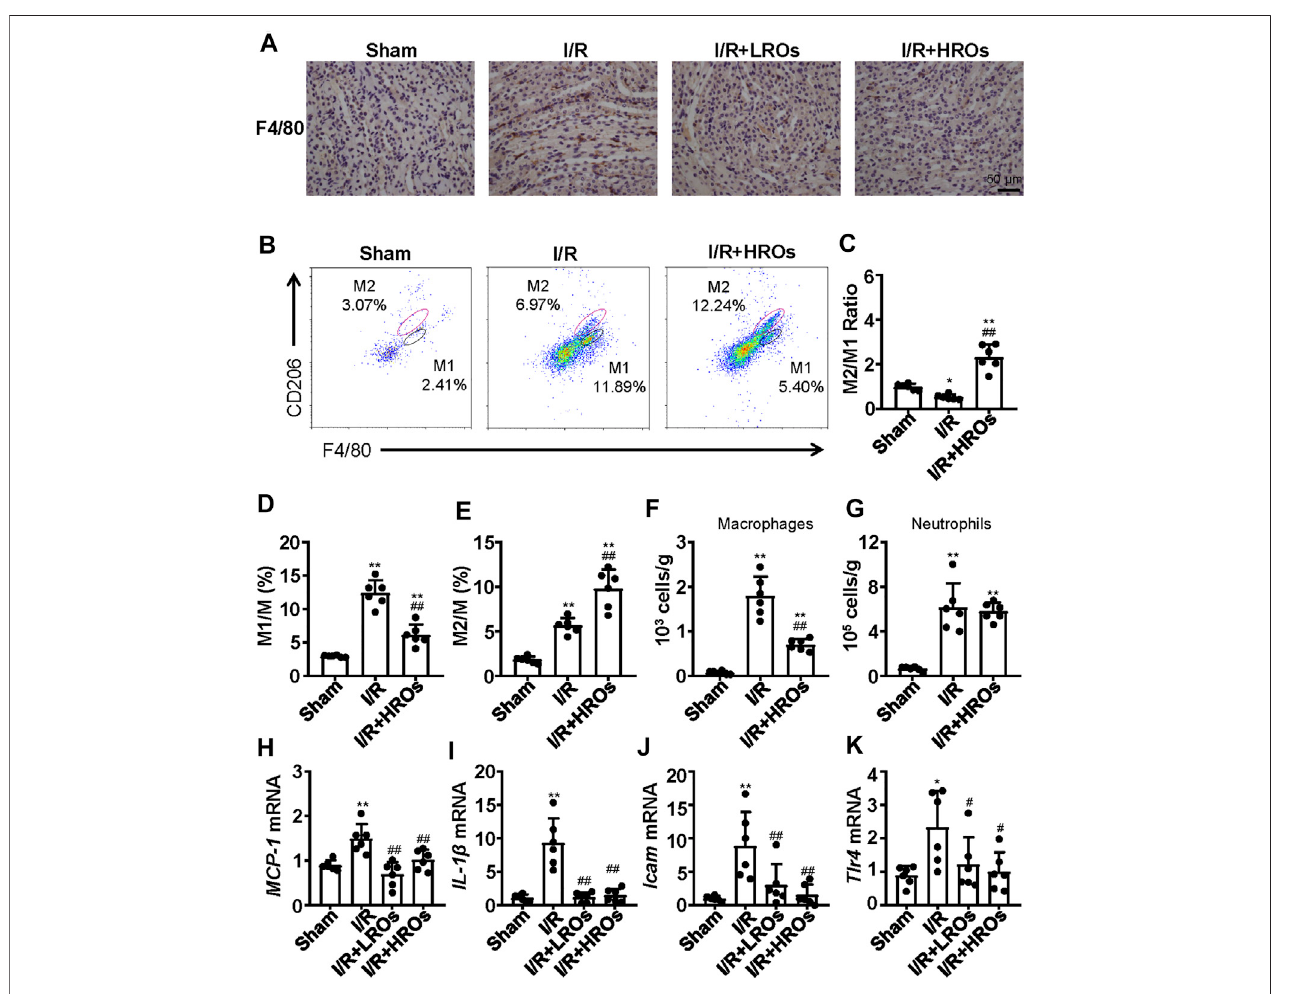
FIGURE5| Effectsofriclinoctaoseonmacrophagepolarizationandmacrophagein fi ltration. (A) Typicalimmunohistochemicalstainingforanti-F4/80ofthekidneysintheshamgroup, I/Rgroup,I/R+LROsgroup,andI/R+HROsgroup. (B) Representativeplotchatsof fl